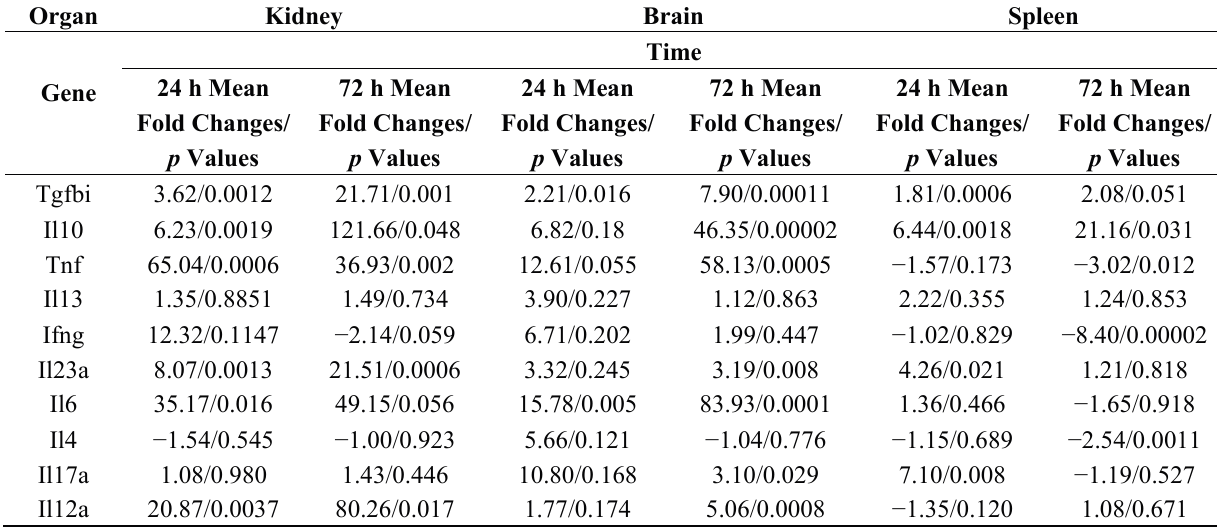
Table 2. The fold changes of cytokine genes in whole kidney, spleen and brain towards systemic C. albicans infection at 24 and 72 h post-infection. The fold changes were calculated based on the normalization of the target gene to the reference genes, β -actin, GAPDH, 18s ribosomal RNA and beta-2 microglobulin using the ΔΔ C mice as compared to that in uninfected mice. Results were means of fold changes of three biological replicates and highlighted parts are the genes which were statistically significant at p < 0.05 as compared with uninfected group,